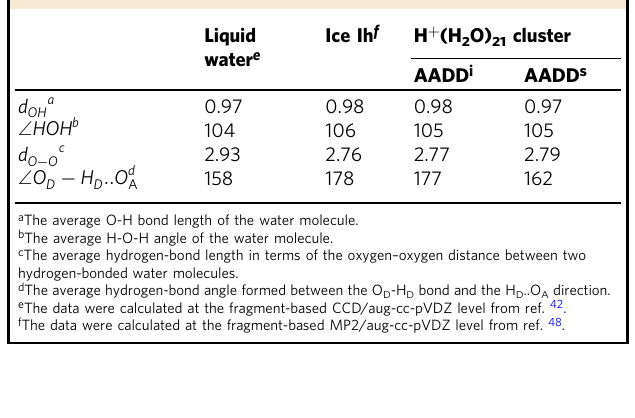
Fig. 3 Assignments of O-H stretching features of neutral water molecules. (Upper panel) Enlarged view of the VQDPT2 spectrum in the range of O-H stretching of neutral water molecules. The assignments are indicated in colors and labels according to the type of corresponding water molecules. Notations: Fermi resonance (Fermi), combination band (Comb), mixed vibration with different type of water ( + ). (Lower panel) The O-H stretching motions of the neutral water molecules. (A) Free O-H stretch of the AAD-type water molecule. (B), (C) Two DDA-type water molecules in feature ( a ). (D), (E) The AADD s -type water molecules in feature ( b ). (F), (G), (H) The AAD, AADD s , and DDA h -type water molecules in feature ( c ). (I), (J) The DDA h and AAD-type water molecules in feature ( d ). (K) The AAD-type water molecule in feature ( e ). (L) The AADD i -type water molecule in feature ( f ). Table 1 The structural comparison of the simulated liquid water, ice Ih, and the H + (H 2 O) 21 cluster ( d in angstrom, and ∠ in degree). The results for the H + (H 2 O) 21 cluster are average values over 4 cluster structures shown in Fig. 5.